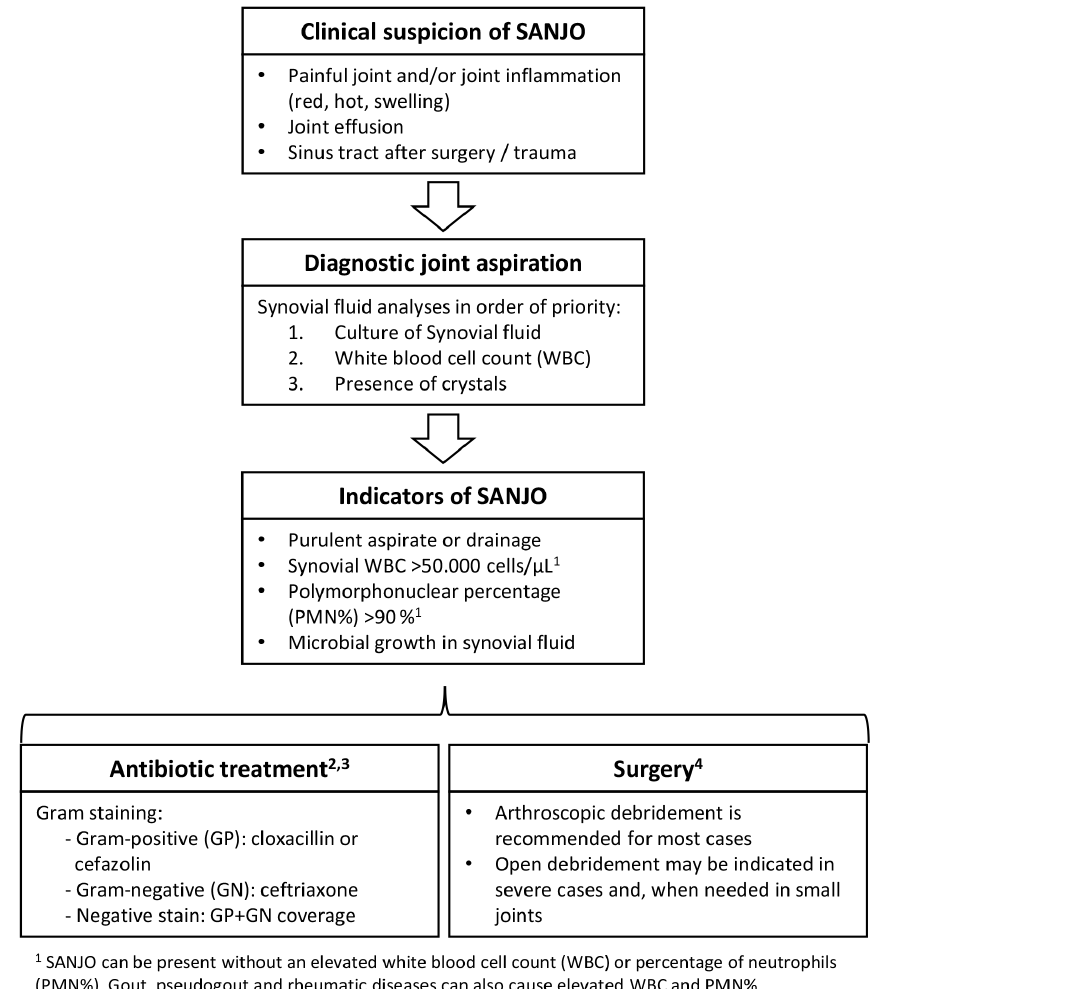
Figure 2. Management of septic arthritis in native joints